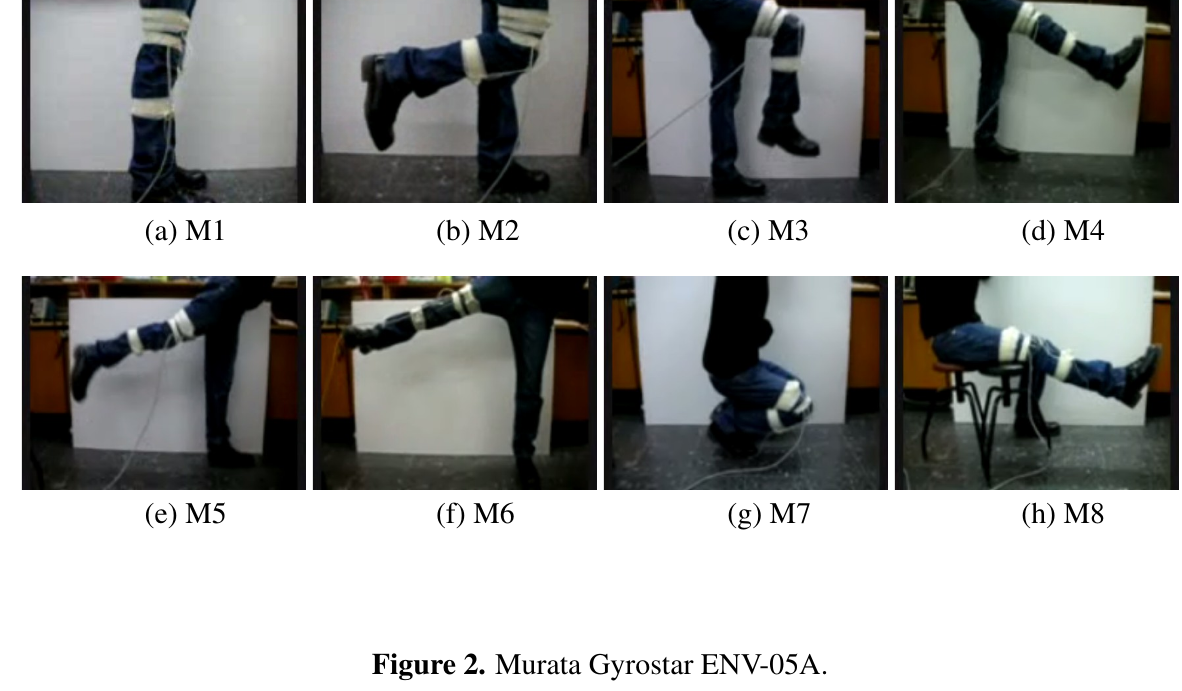
Figure 2. Murata Gyrostar